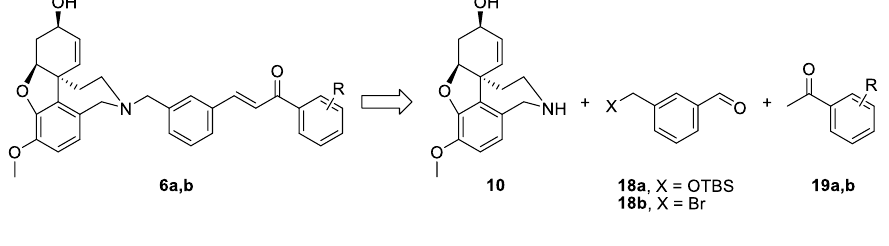
Figure 5. Retrosynthetic analysis of compounds 6a , b . Molecules 2020 , 25 , x FOR PEER